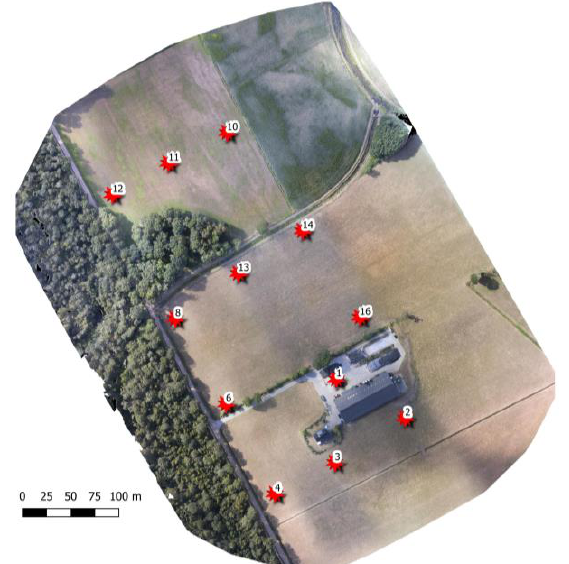
Figure 3: Distribution of GCPs for experimental test flights in Bentelo (NL). GCP ID 13 was used for processing scenario with only one GCP; GCP ID 1, 2, 4, 10, 12, 13 for processing scenarios with six